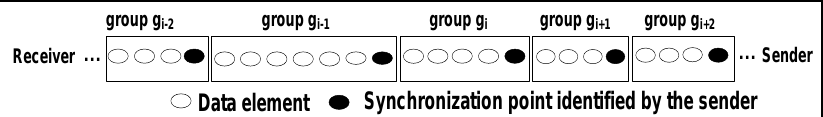
Synchronization point identified by the senderData